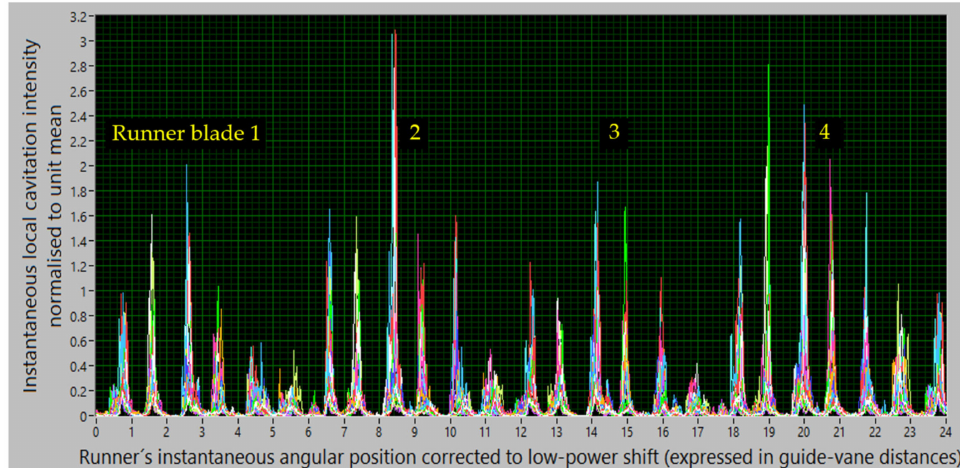
Figure 3. Front panel of the multidimensional data acquisition processor. The simplest description of cavitation comes out online after half an hour of measurement on the prototype. More compli- Figure 22. These data acquired at many power values and corrected in a way to eliminate the cated descriptions require days or weeks of recorded data analysis by a trained user. circumferential shifts shown in Figure 12a demonstrate the differences in cavitation on the four runner blades. As can be seen, their interaction with the guide vanes varies in strength and distribution over the involved guide vanes.